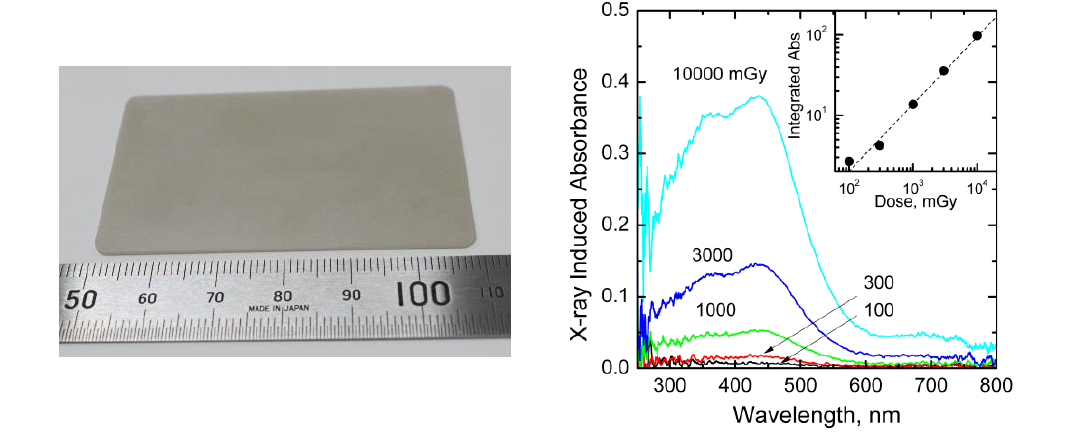
Figure 1. ( left ) AlN ceramic plate (SHAPAL ® ) manufactured by Tokuyama Corp. ( right ) X-ray–induced absorbance as a function of X-ray dose irradiated. The inset is the integrated absorbance signal vs. the corresponding dose.